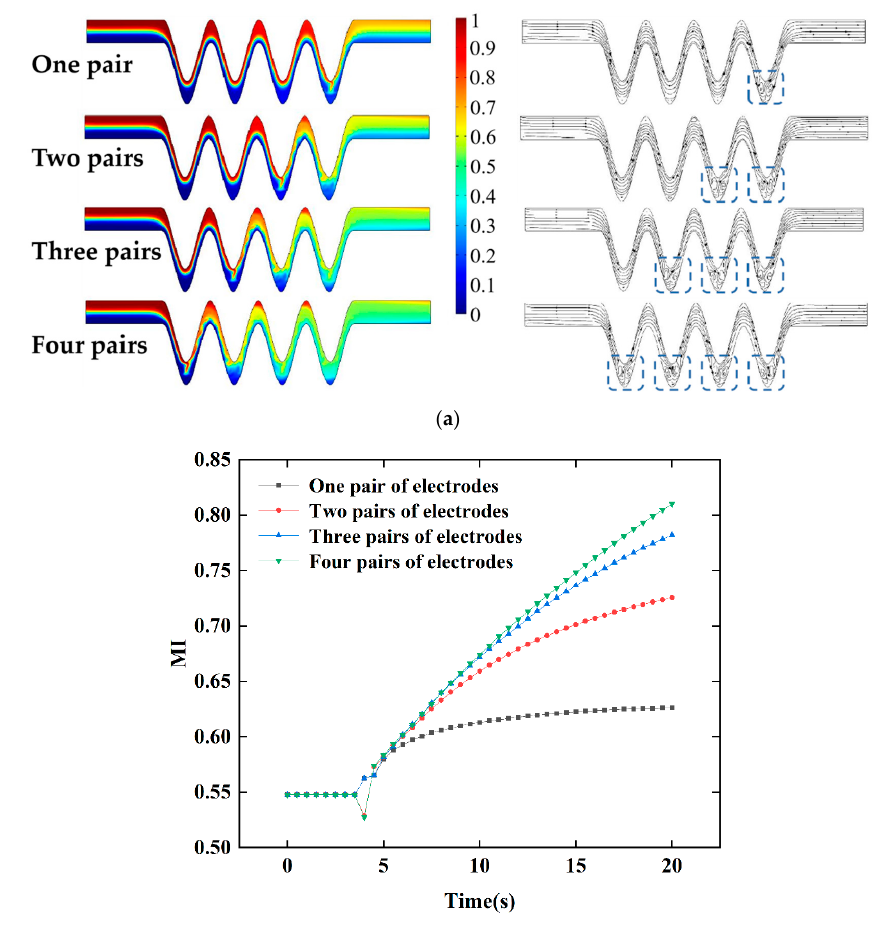
Figure 11. Distributions of electrode pairs positions: ( a ) one pair, ( b ) two pairs, ( c ) three pairs, ( d ) four pairs.